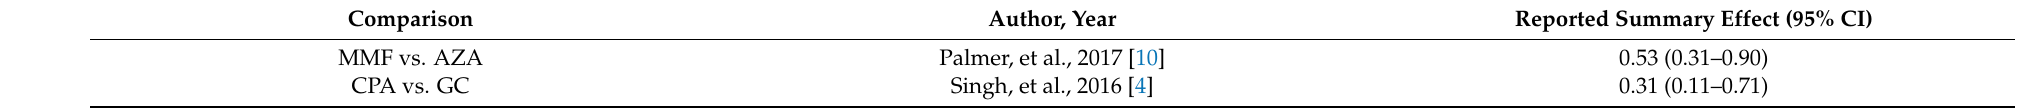
Table 5. Relapse during maintenance therapy of lupus nephritis (Network meta-analysis).